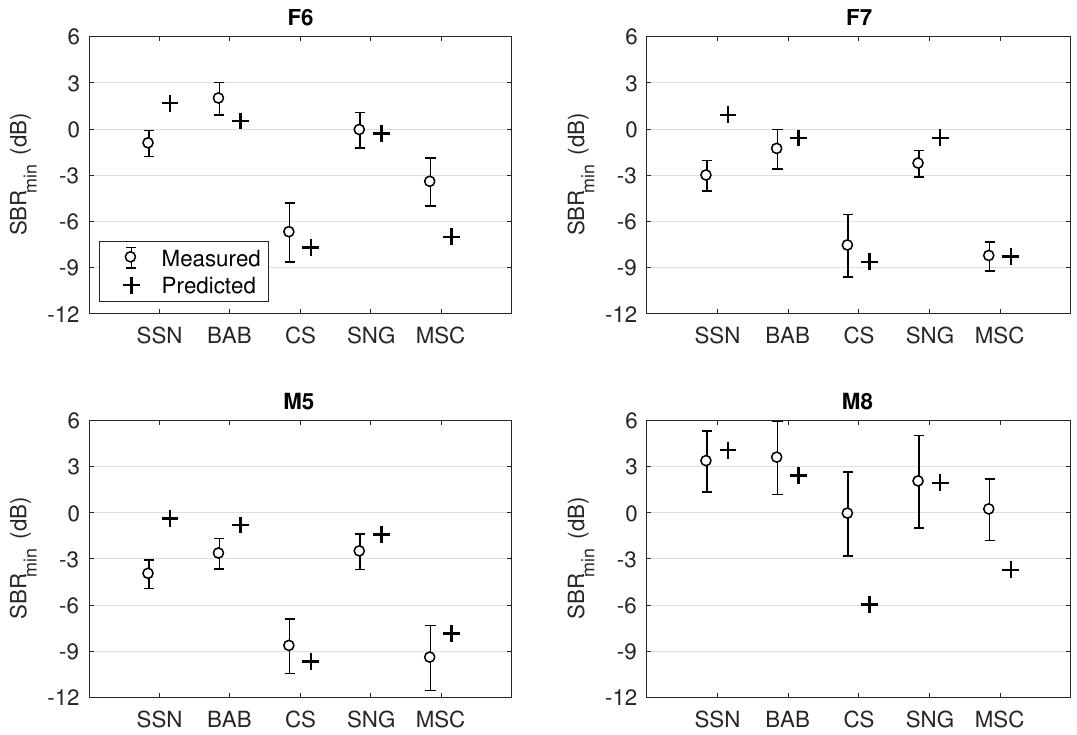
Figure 3. Measured (circle) and predicted (cross) lowest speech-to-background ratio (SBR min ) in speech-shaped noise (SSN), babble (BAB), competing speech (CS), song (SNG) and the same song with vocal track being removed (MSC), grouped by talker. Error bar indicates 95% confidence interval of the mean. Predicted SBR min corresponds to BiDWGP of 0.5 in each